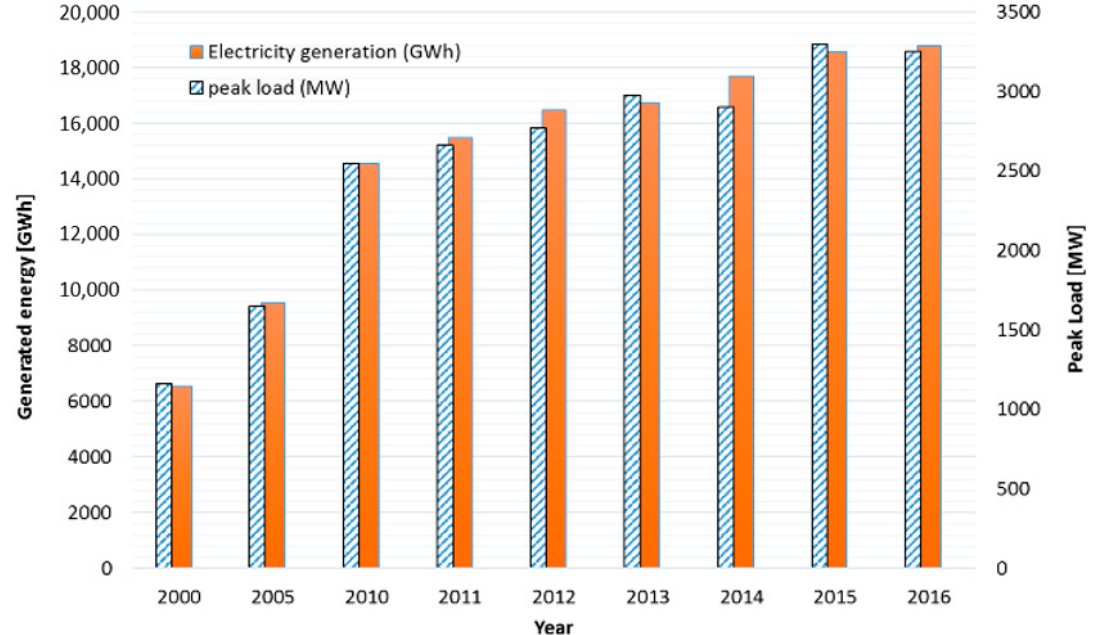
Figure 1. Electricity generation (GWh) and peak load (MW) for the period 2000–2016 (based on the data from [2]).